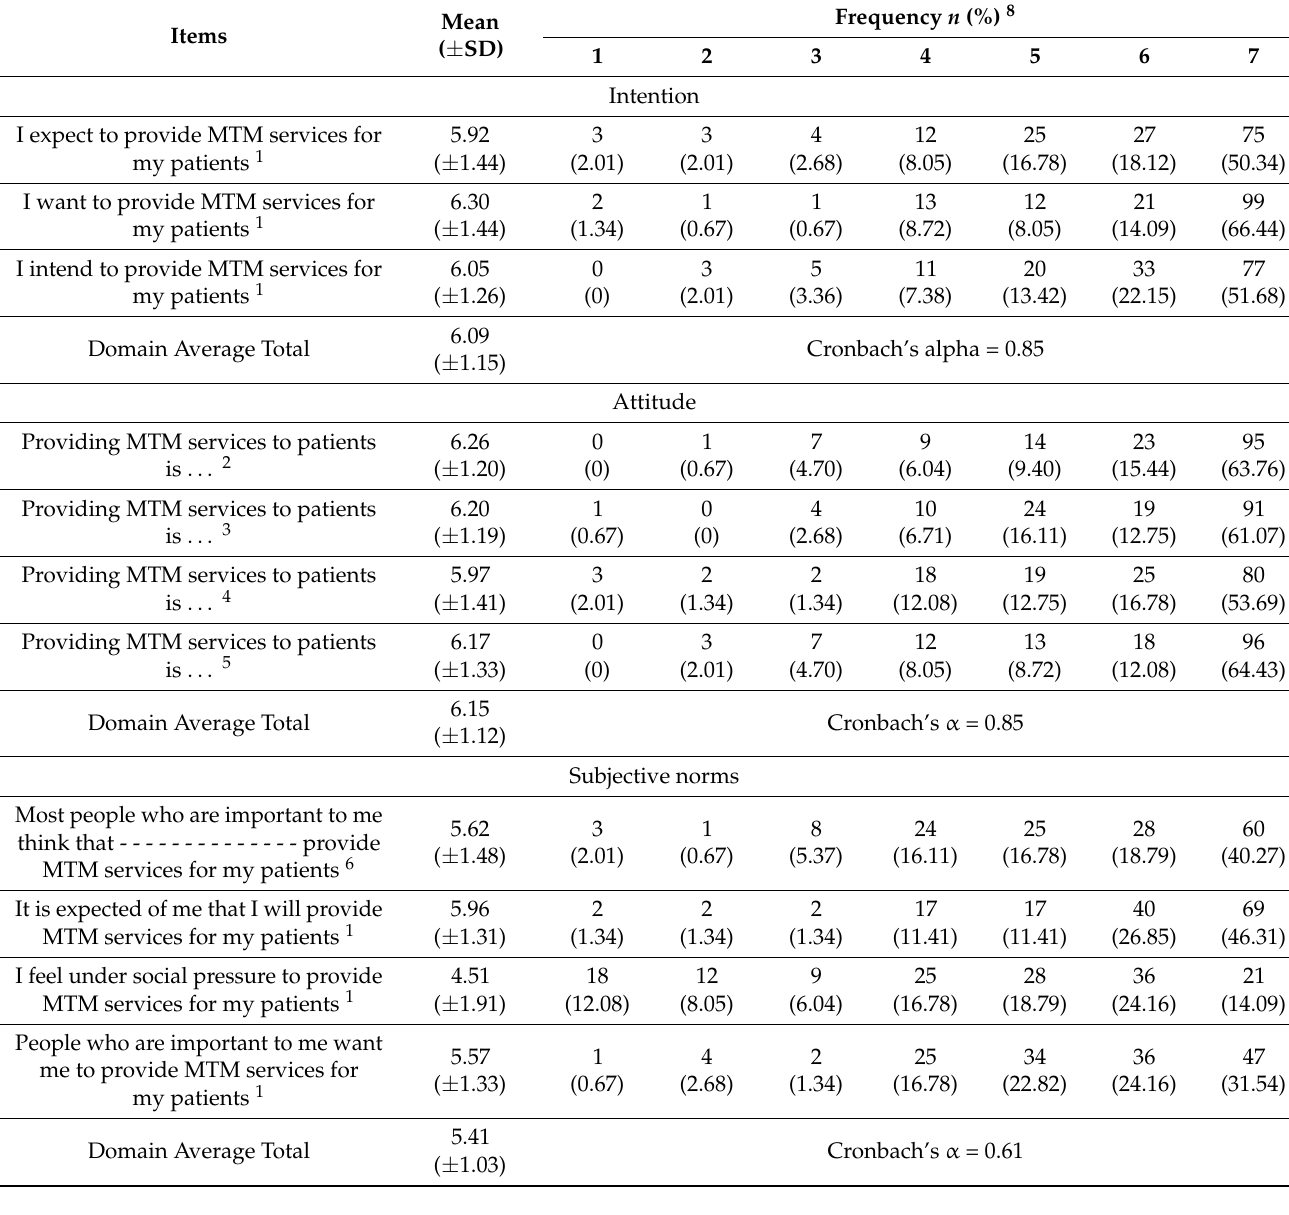
Table 2. Descriptive statics and reliability of TPB construct (n =